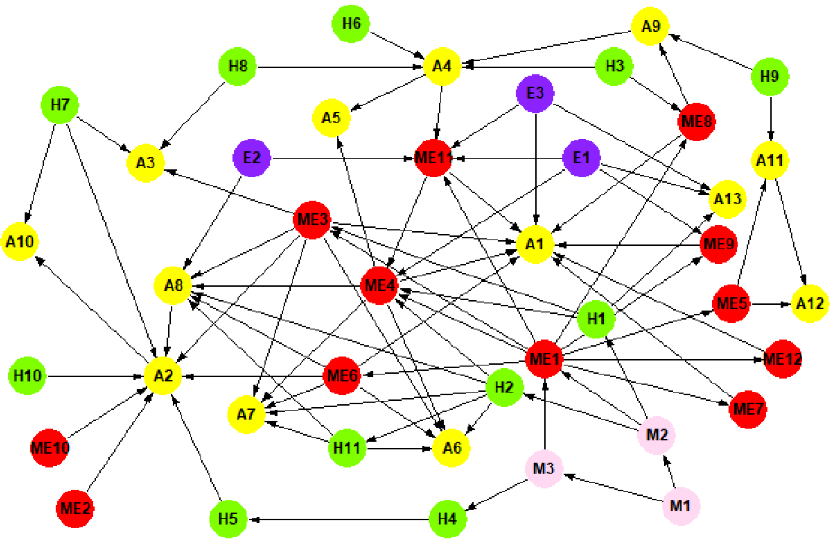
Figure 4. Subway operation accidents causation network (refer to Tables 1 and 3 for the meaning of the symbols).